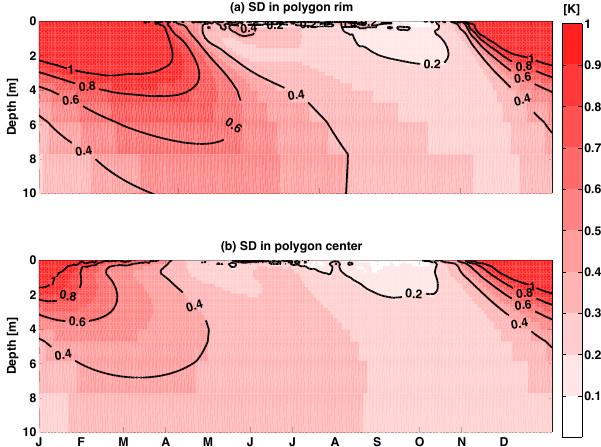
Figure 9. Time series of soil temperature spatial standard devia- tion for “SR = on + physics = 2-D” at polygon rim (a) and polygon center (b)